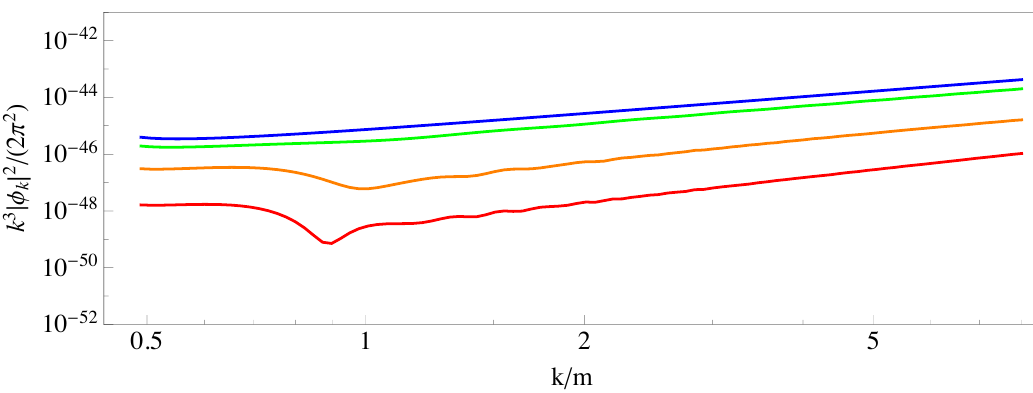
Figure 18 . The spectrum of the (cid:13)uctuations (cid:14)(cid:30) k of the canonically normalised volume modulus in the LVS. The spectrum is shown as a function of the comoving momentum k at di(cid:11)erent moments in time: the initial spectrum ( a = 1) (blue), before the (cid:12)rst oscillation of (cid:30) ( a ’ 1 : 5) (green), after eight oscillations ( a ’ 4 : 8) (orange), and after 47 oscillations ( a ’ 14 : 2) (red).